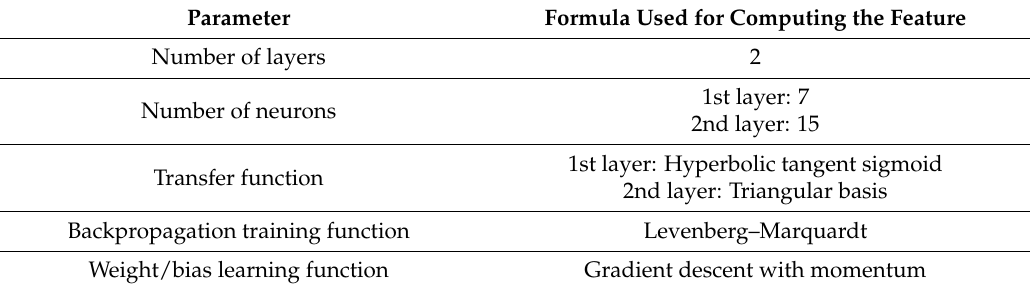
Table 3. Values of multilayer perceptron (MLP) neural network parameters used for the selection of the color